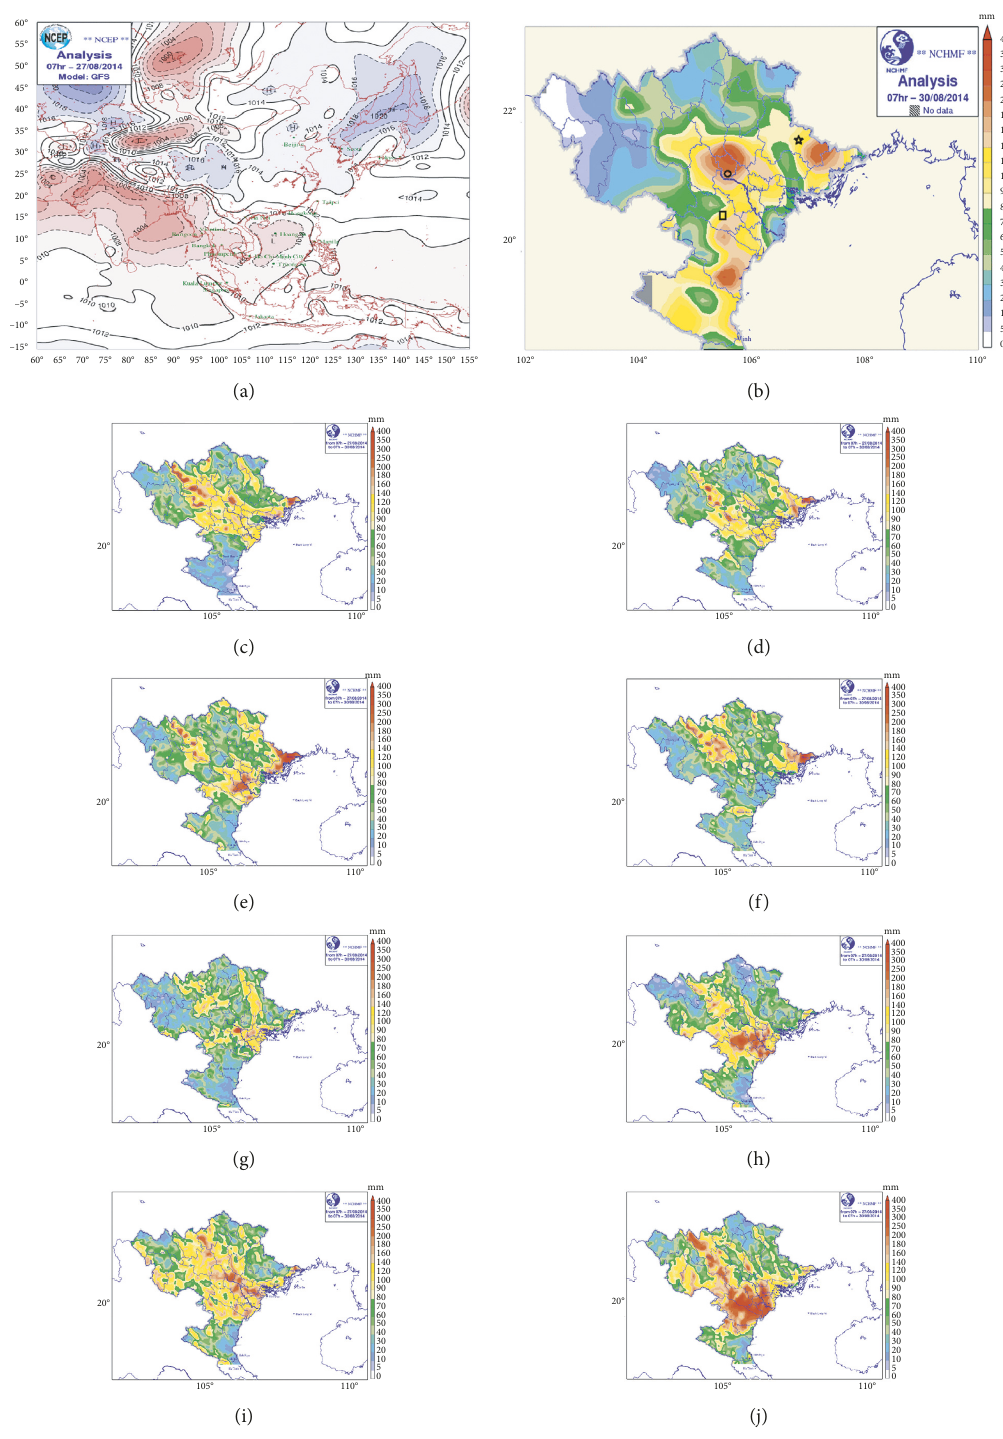
Figure 1: Example of impact of different physical parameterization schemes on heavy rain forecast with the WRF-ARW model (5km horizontal resolution) over the Bac Bo area (the northern part of Vietnam), issued at 00UTC 27/08/2014. (a) Analysis of mean sea level pressure from the GFS at 00UTC 27/08/2014. (b) 72h accumulated precipitation from synoptic observation from 00UTC 27/08/2014 to 00UTC 30/08/2014. 72h accumulated precipitation forecast from the WRF-ARW model with the configuration of KF cumulus param- eterization and shortwave radiation and cloud microphysics schemes: (c) KF-Lin-Duh-MYJ; (d) KF-WSM3-Duh-MYJ; (e) KF-WSM5-God- MYJ; (f) KF-WSM5-God-YSU. 72 h accumulated precipitation forecast from the WRF-ARW model with the configuration of BMJ cumulus parameterization: (g) BMJ-Lin-Duh-MYJ; (h) BMJ-WSM3-Duh-MYJ; (i) BMJ-WSM5-God-MYJ; (j) BMJ-WSM5-God-YSU. More ex- planation of model configurations from (c) to (j) experiments can be found in Table